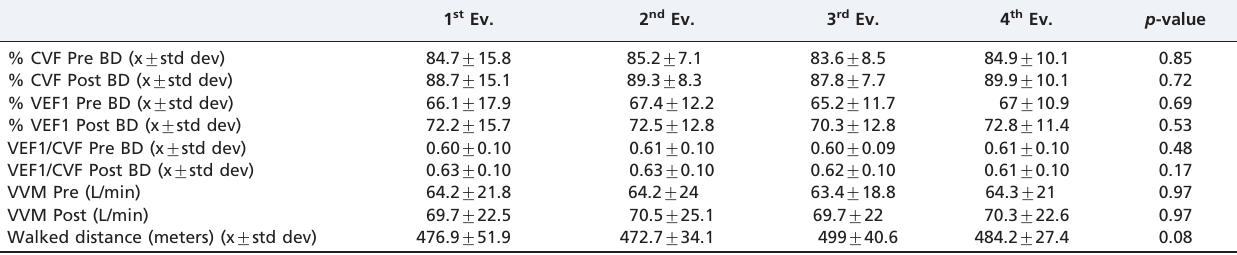
Table 1 - The lung function variables and the results of the 6-minute walking test during the 4 patient evaluations (n = 14) . 1 st Ev.